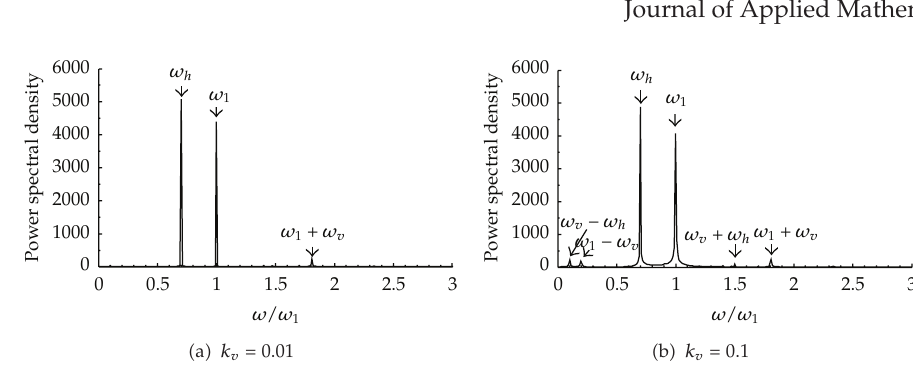
Figure 13: Spectral charts corresponding to the Figure